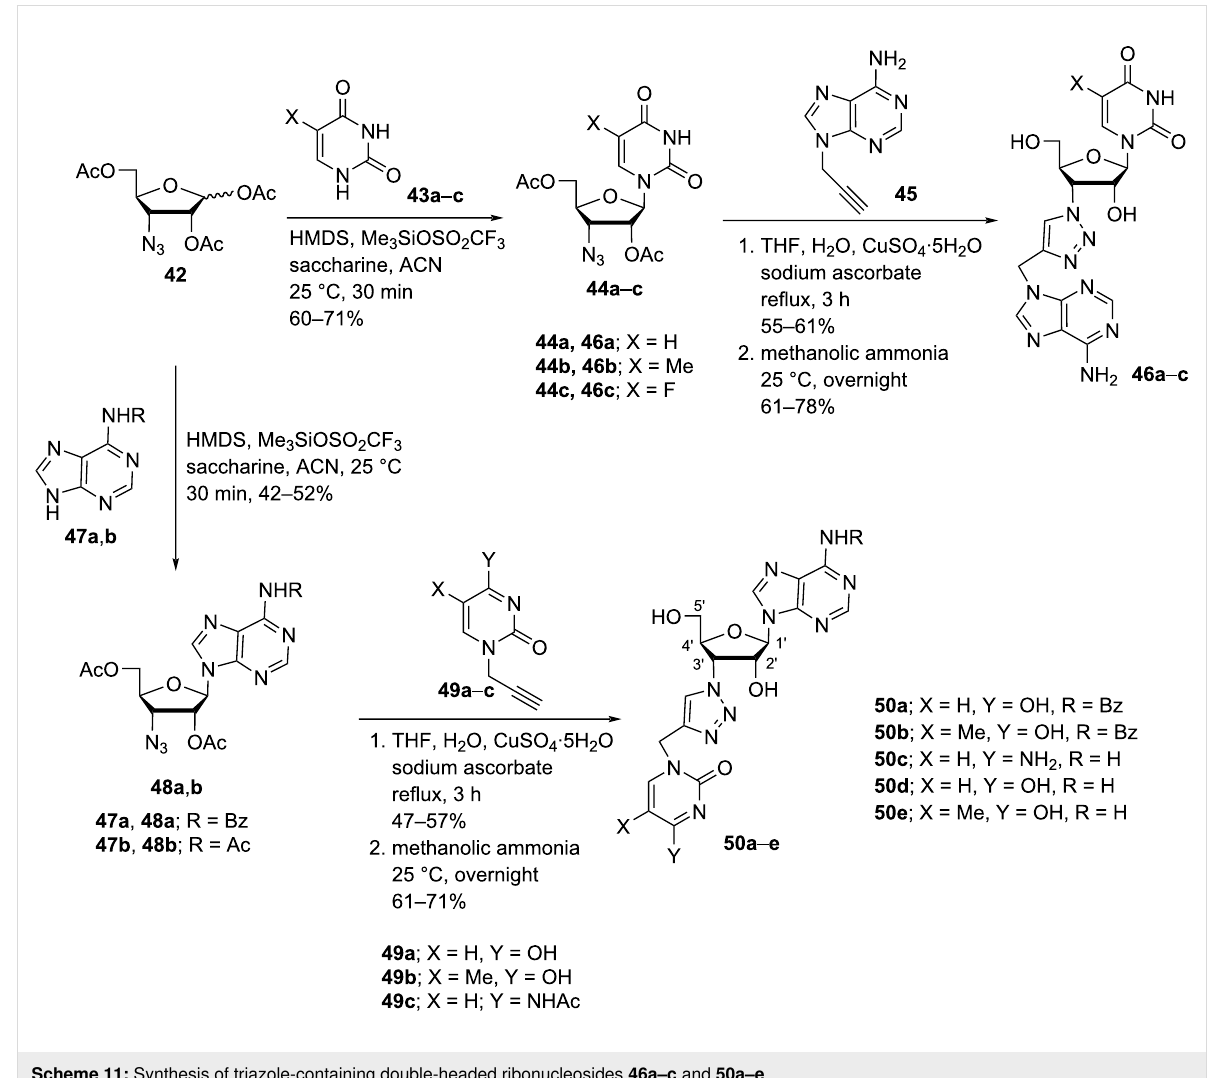
Scheme 11: Synthesis of triazole-containing double-headed ribonucleosides 46a–c and 50a–e .